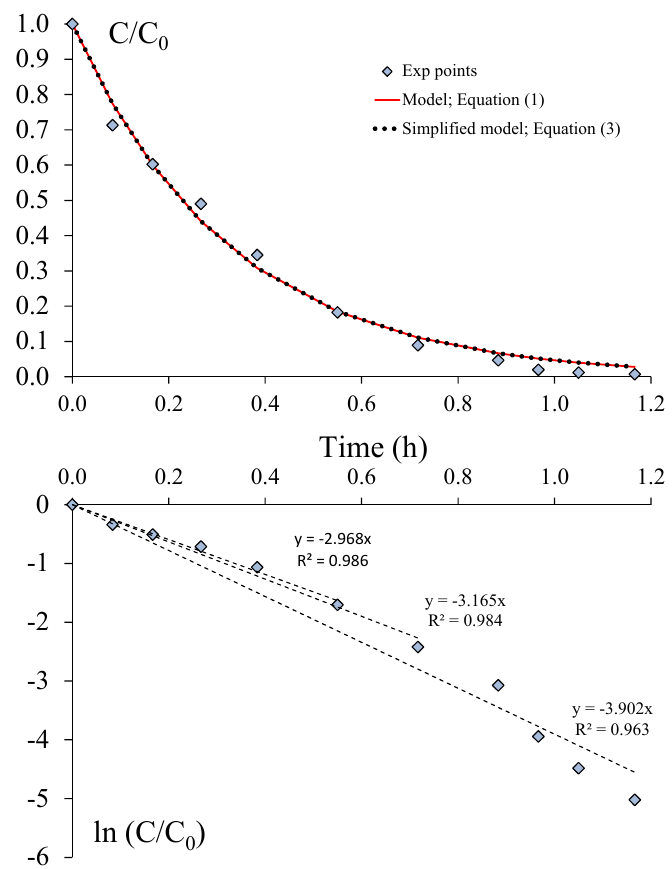
Figure 3. Typical change in toluene concentration over time. Experimental data and models (Exp 10; I = 0.35 mW · cm − 2 ; v = 1.0 m · s − 1 ; C 0 = 1000